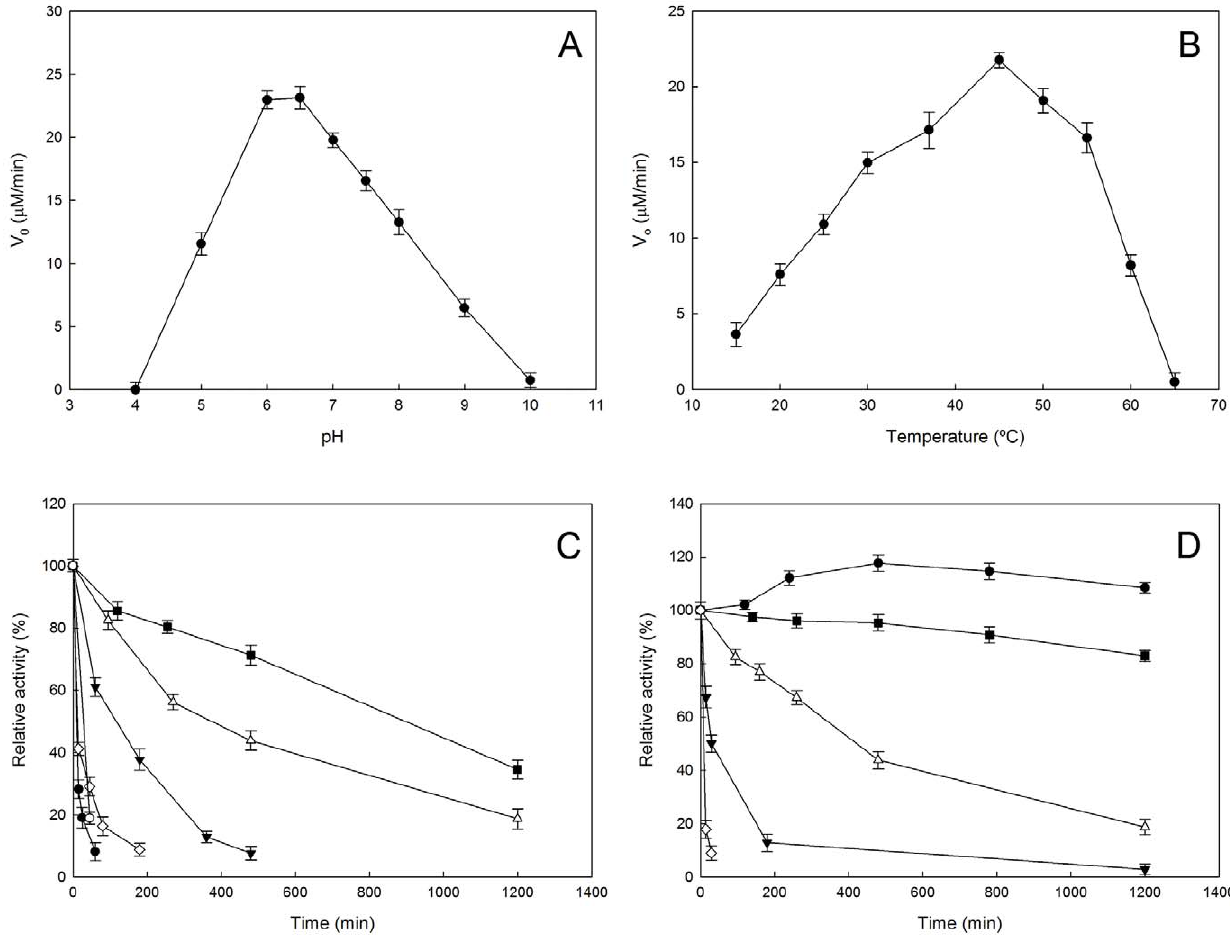
Figure 2. Effect of pH and temperature on OiNIC activity and stability. A) pH profile for OiNIC determined by HPLC. The assay conditions at 37 u C were 1 mM nicotinamide, 0.67 m g of OiNIC. The buffers (100 mM) used were sodium acetate pH 4.0–6.0, sodium phosphate pH 7.0–8.0, Tris-HCl N pH 9.0 and glycine pH 10.0. B) Temperature profile. Assay conditions were the same as above at pH 7.3 at different temperatures from 15 to 65 u C. C) ), pH 6 ( & ), pH 7.3 ( D ), pH 8 ( . ), pH 9 ( e ) and pH 10( # ). Buffer compositions were the same as pH stability. OiNIC was incubated at 37 u C at pH 5 ( N above. Residual activity was measured spectrophotometrically under the standard reaction at 37 u C. D) Temperature stability. OiNIC was incubated at ), 20 ( & ), 37 ( D ), 45 ( . ) and 55 u C ( e ) in 100 mM sodium phosphate buffer pH 7.3. Residual activity was measured spectrophotometrically 4 (